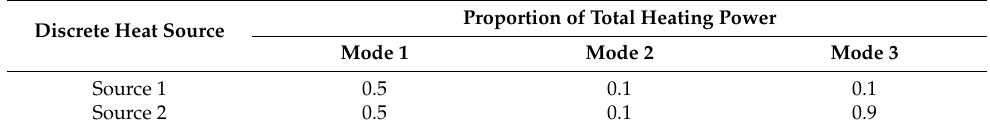
Table 5. Different numerical distributions of discrete heat sources.